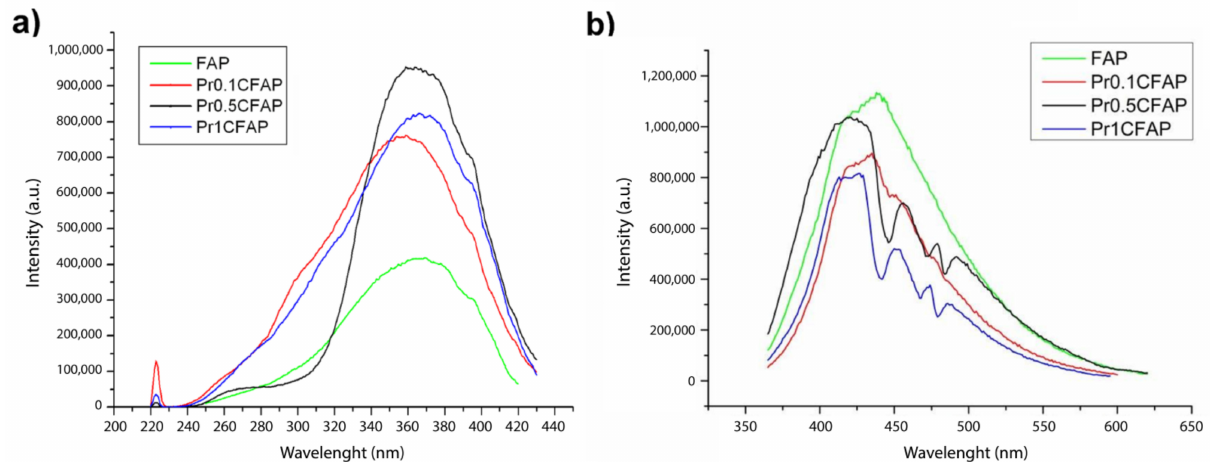
Figure 6. ( a ) Excitation (for emission max. at 435 nm) ( b ) and emission spectra (under excitation of 350 nm) of FAP and PrxCFAP samples obtained at room